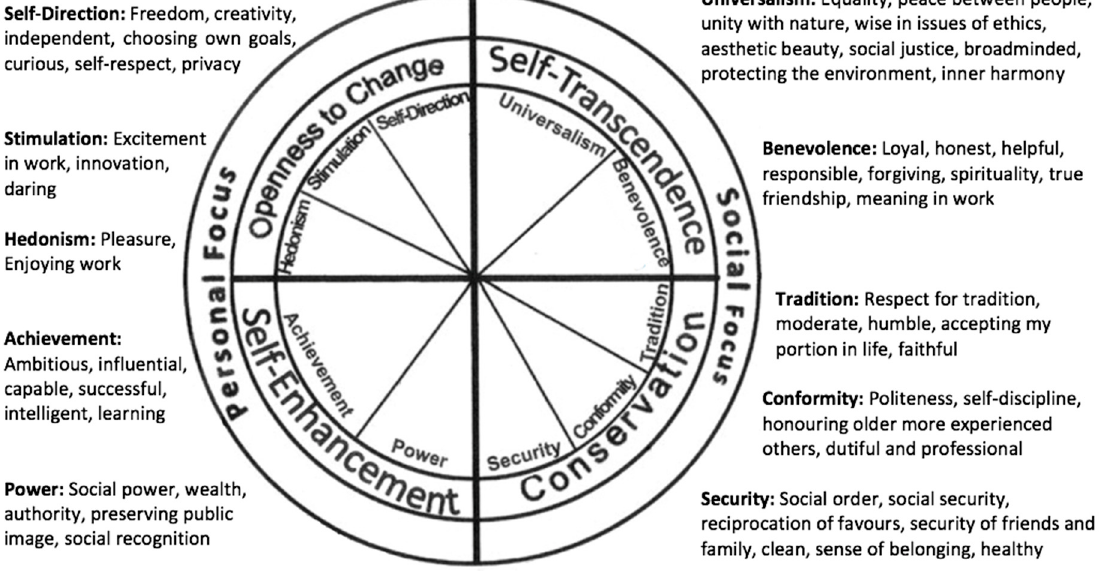
Figure 1. Circular structure of values (adapted from Sortheix and Schwartz 2017), with corresponding value items (as adapted by Mills et al. 2009). Table 1. Value categories and their defining goals (Schwartz